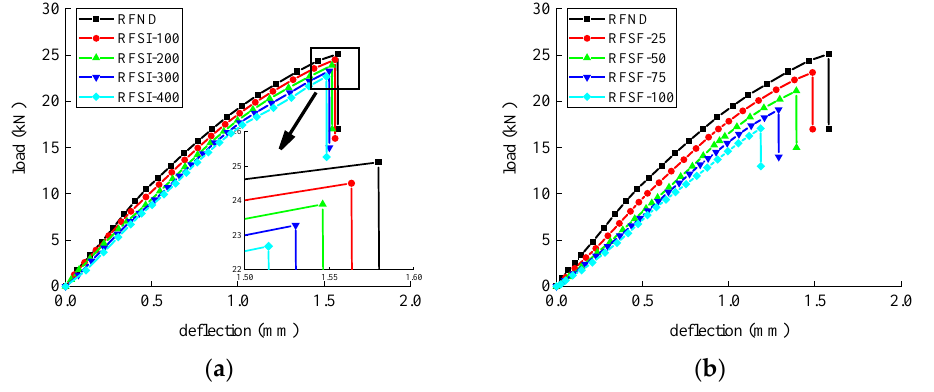
Figure 29. Load-deflection curve of unreinforced concrete flexural specimen: ( a ) chlorine salt immersion environment and ( b ) salt-freeze coupled environment.